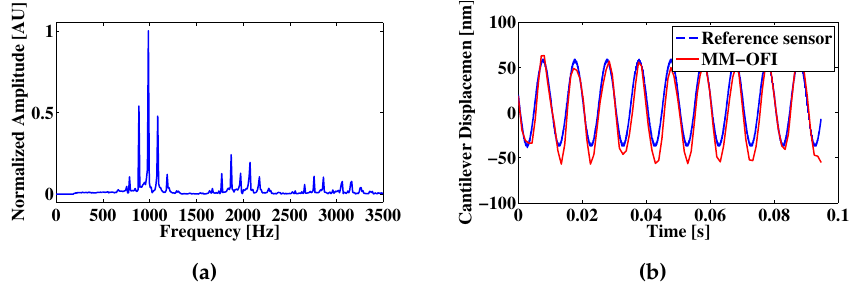
Figure 10. ( a ) Frequency analysis of a mechanically-modulated OFI signal during an experimental cantilever vibrating at 100 Hz with a peak to peak amplitude of 100 nm; ( b ) Comparison between the internal capacitive sensor response of the PI-LISA PZT (dashed line) and the mechanically-modulated OFI sensor (solid